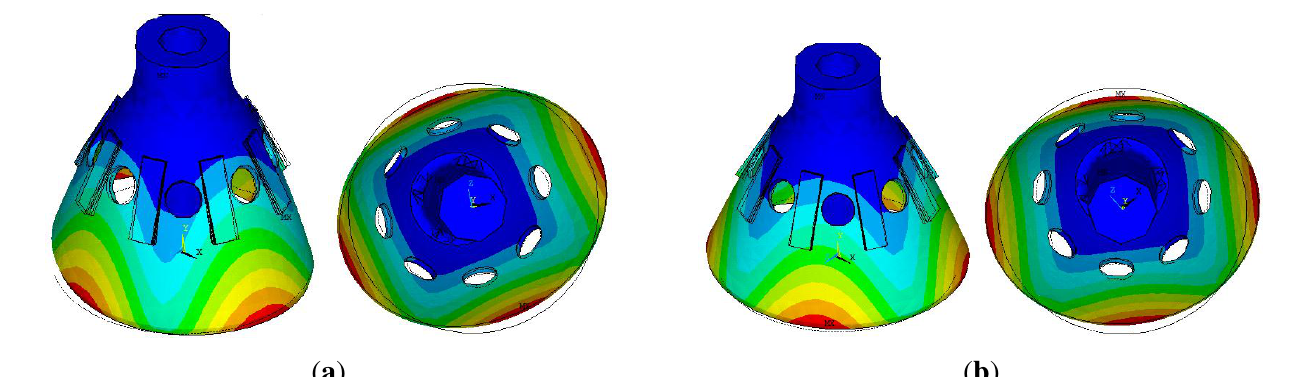
Figure 9. The result of mode